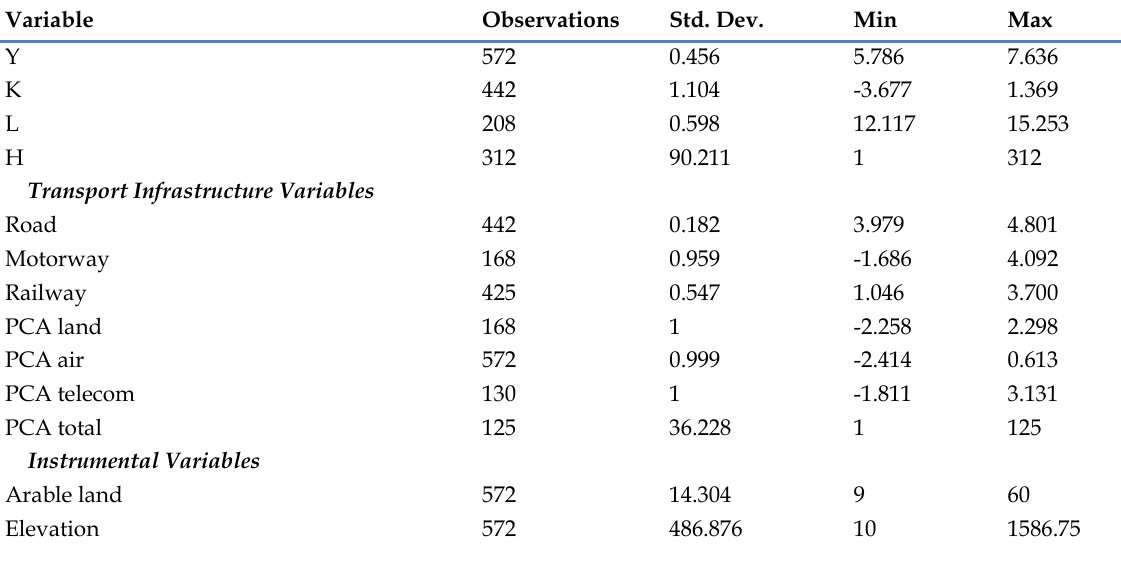
Table 2. Descriptive statistics of the